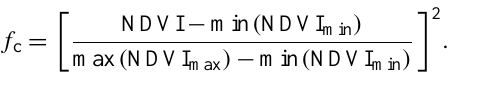
derived from NDVI data using the following